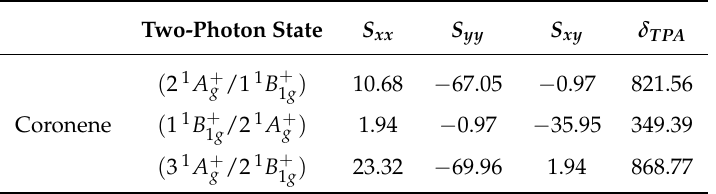
Table 4. Two-photon transition matrix elements along with the two-photon absorption (TPA) cross-section for the lowest two-photon states in the unsubstituted coronene molecule. Possible symmetry labels are provided wherever a unique symmetry label cannot be determined. Transition matrix elements, as well as TPA cross-sections are given in atomic